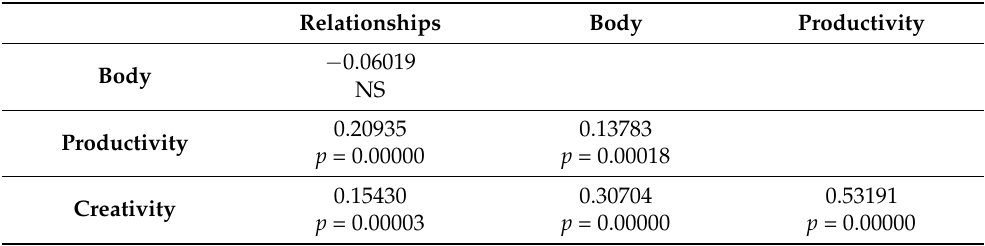
Table 3. Correlations between studied areas. The value of Spearman’s R and the corresponding statistical significance ( P ) are presented. Relationships Body Productivity